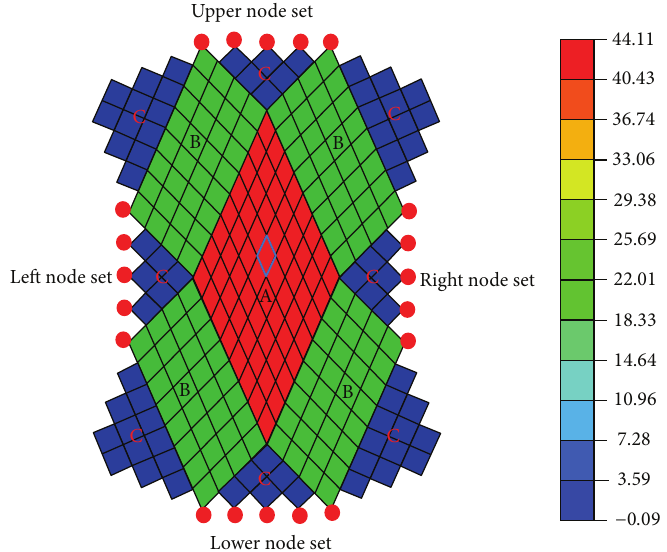
Figure 2: The BBE FE model. Force boundary conditions are applied to the right and left centrally located node sets, and vertical displacement boundary conditions are applied to the upper and lower centrally located node sets. The colour legend indicates the shear angle. The three different deformations occurring in Regions A, B and, C of the test specimen are clearly visible. The shear angle in Region A is taken from the highlighted